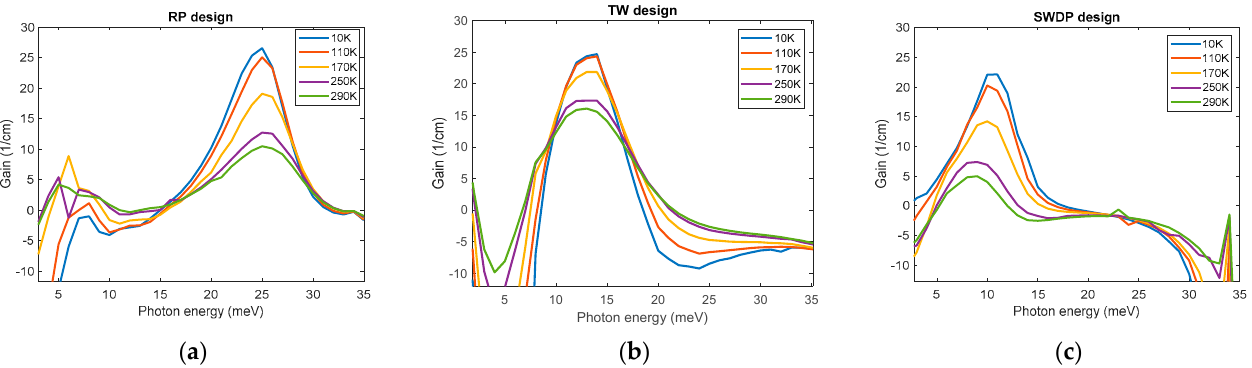
Figure 2. Optical gain as a function of photon energy for various temperatures: ( a ) for the RP design at a bias voltage of 86 mV/module, ( b ) for the TW design at a bias voltage of 70 mV/module, and ( c ) for the SWDP design at a bias voltage of 46 mV/module.